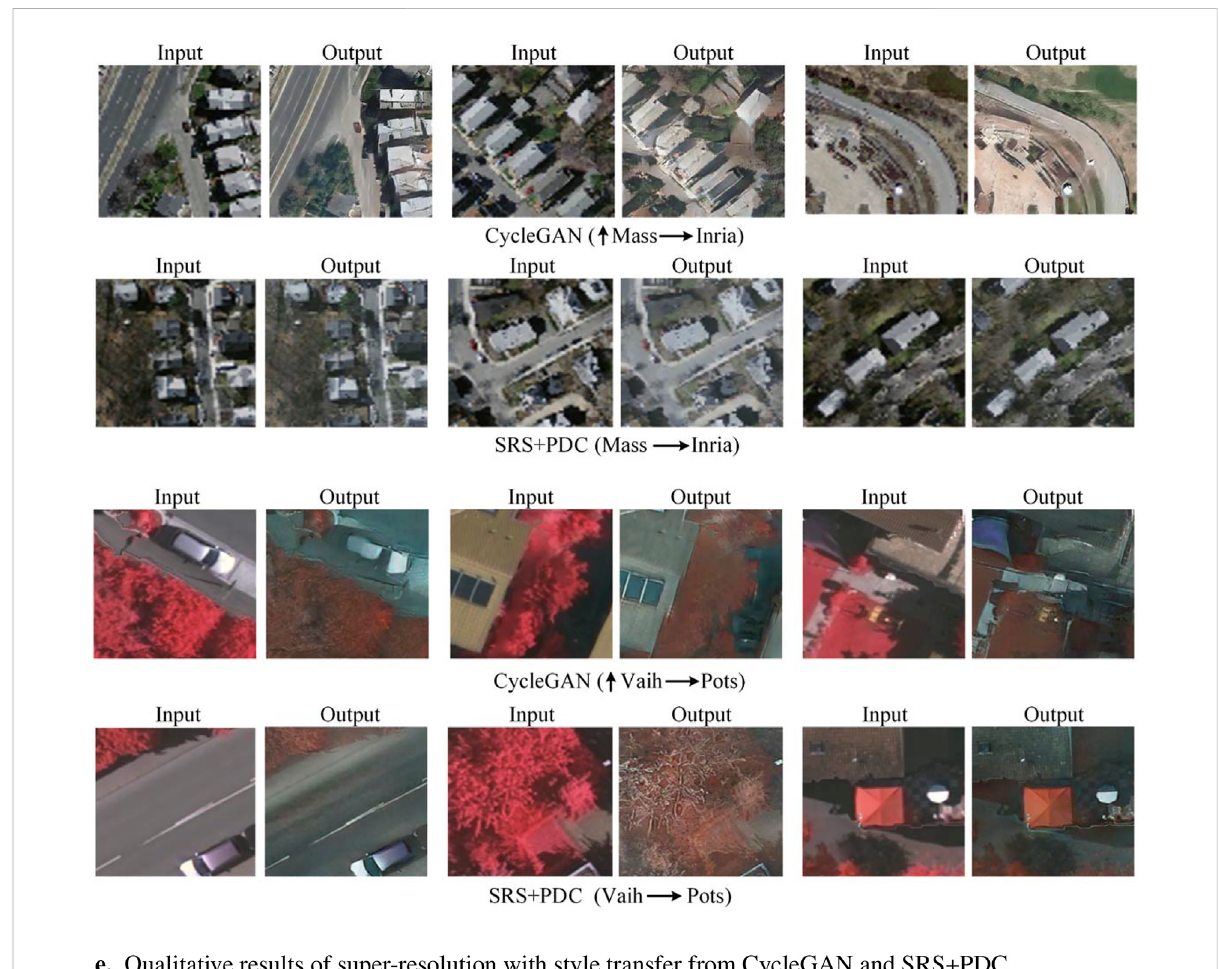
FIGURE 5 Qualitative results of super-resolution with style transfer from CycleGAN and SRS+PDC.